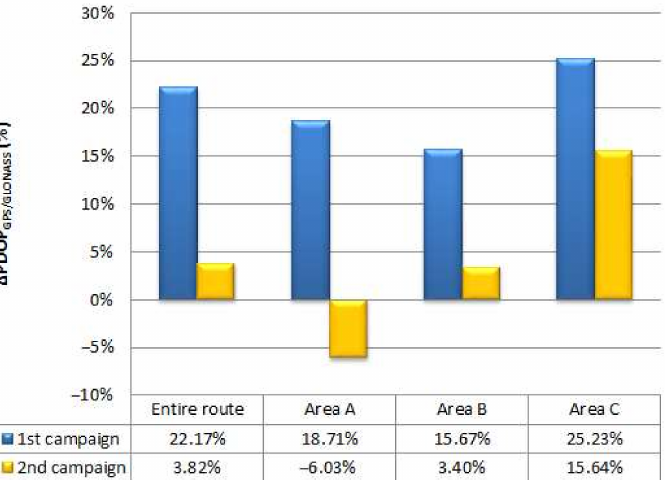
Figure 14. The relative percentage change in the average PDOP values between the continuous variant and the optimal variant for the GPS/GLONASS solution.